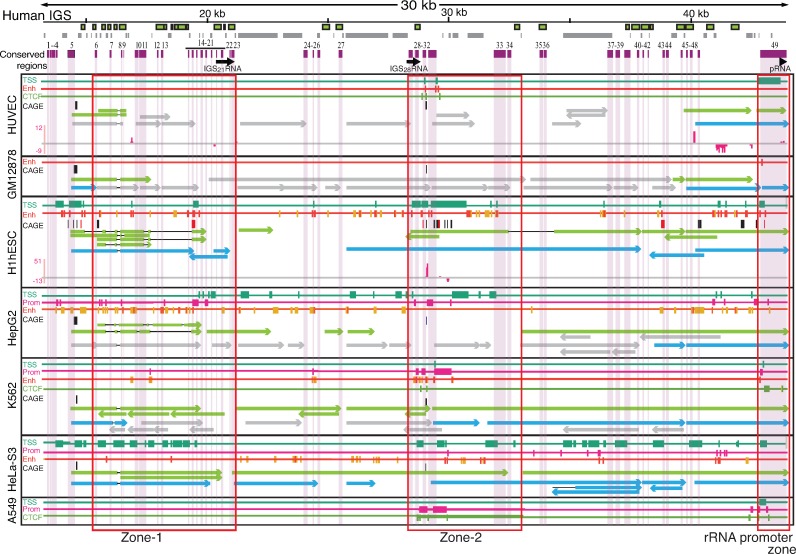
Two zones in the human IGS enriched for conserved regions and transcription associated factors.The human IGS is shown at top, with the positions of Alu elements (green boxes), microsatellites (grey boxes), conserved regions (purple boxes), and previously identified IGS noncoding transcripts (black arrows) indicated. Below are chromatin and transcriptional features of seven human cell lines. The positions of the conserved regions are indicated by pale shading. For each cell line the presence of transcriptional start site (TSS), promoter (Prom), enhancer (Enh), and CTCF segmentation states, obtained by merging peaks for histone modification, Pol II and CTCF using Segway, are indicated. Below these, CAGE peaks are shown for the forward (black boxes) and reverse (red boxes) strands (CAGE stem cell data come from H9-hESC, not H1-hESC), followed by long poly(A+) and poly(A-) transcripts (green and blue arrows, respectively) with FPKM values >1; gray arrows indicate transcripts with FPKM < 1. Arrowheads indicate the direction of transcription. Peaks of small RNA are shown in pink. Zones 1 and 2 that are enriched for conserved regions and transcription-associated factors are boxed in red. Not all features have data available for all cell lines.